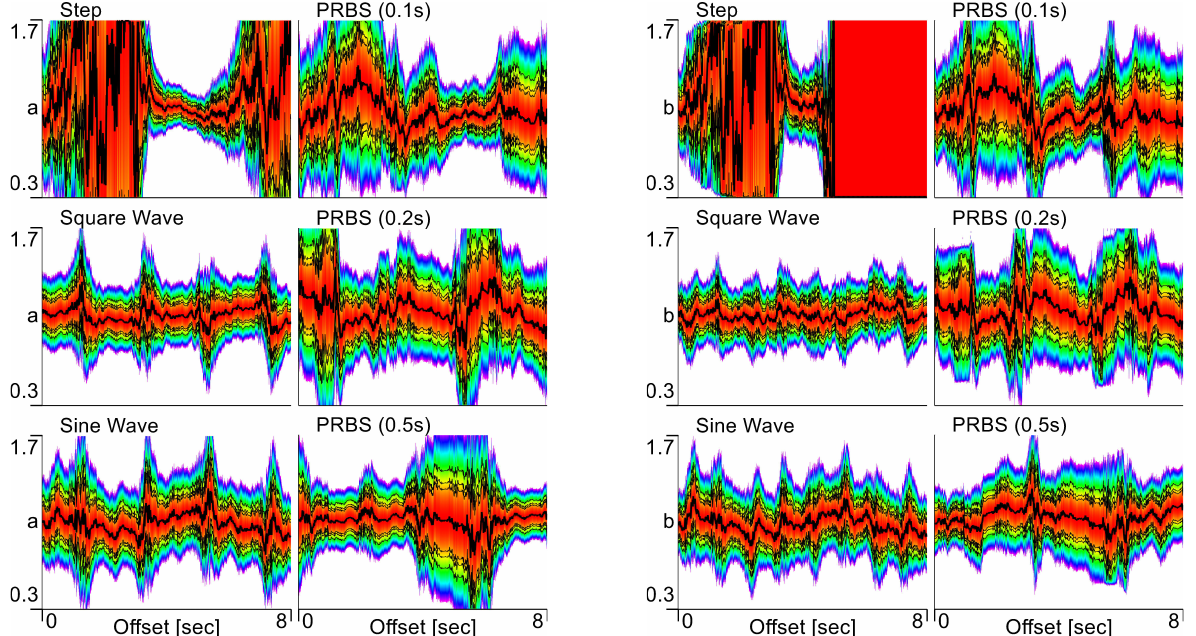
Figure 14: Consistency of dynamic information for identification parameters a (left) and b (right) is examined using a window length of l = 200 samples, equivalently 2 seconds. The window offset is varied on the interval t 0 ∈ [0 , 8[ seconds in steps of w = 1, or equivalently ∆ t = 0 . 01. At each step, the Profile Likelihood method is used to evaluate identifiability of the parameters using the information in the window. The results are plotted as a heat-map with time offset on the horizontal axis, and the thick line represents the optimal parameter estimate for each window. The parameters are examined on the interval [0 . 3 , 1 .